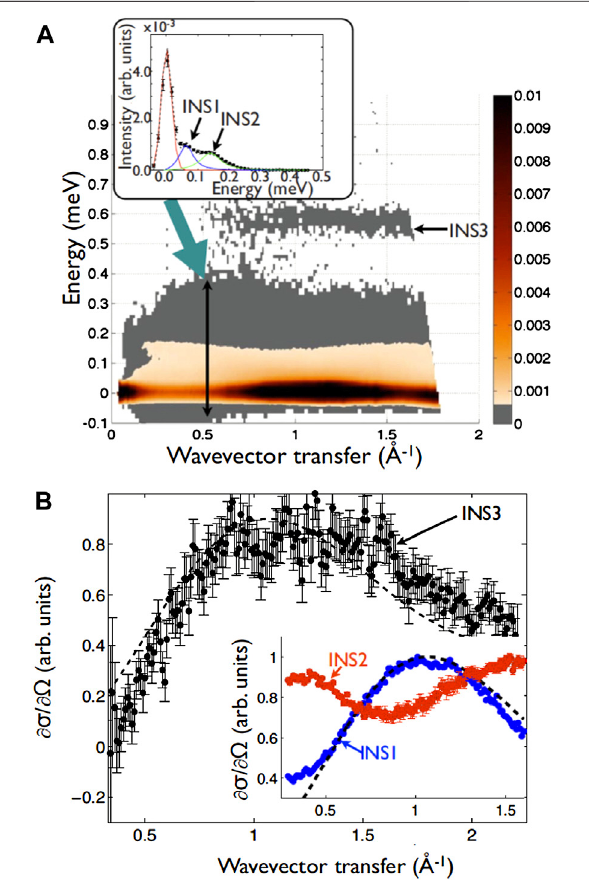
FIGURE 11 | (A) Powder-averaged scattering function S (Q, ω ) of GGG at 0.06 K with incident E i = 1.94 meV. Insert is a cut at wave-vector transfer of Q = 0.5 (cid:2) A − 1 showing the elastic lineshape and two low-lying excitations with the corresponding fi ts. (B) Q-dependent integrated intensity of INS3. The dashed lines correspond to a model of short-range AF correlation with only near neighbor interactions. The inset shows the integrated intensities of INS1 and INS2